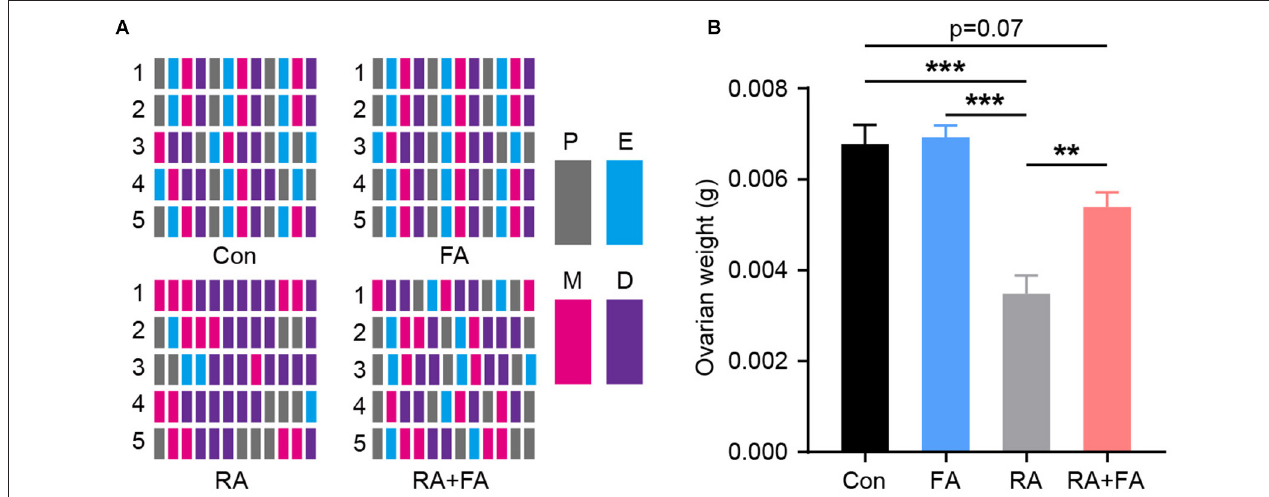
FIGURE 1 | Effect of folic acid pre-administration on menstrual cycle and ovarian atrophy after radiation injury. (A) Raster plot schematic representing the menstrual cycle following injury due to radiation exposure. Representative raster plots were selected from five mice in each group which were closest to the mean levels. P, proestrus; E, estrus; M, metestrus; D, diestrus. (B) Quantification of the ovarian weight for each group. Error bars, standard error of mean (SEM). N = 8, ** p < 0.01 and *** p <